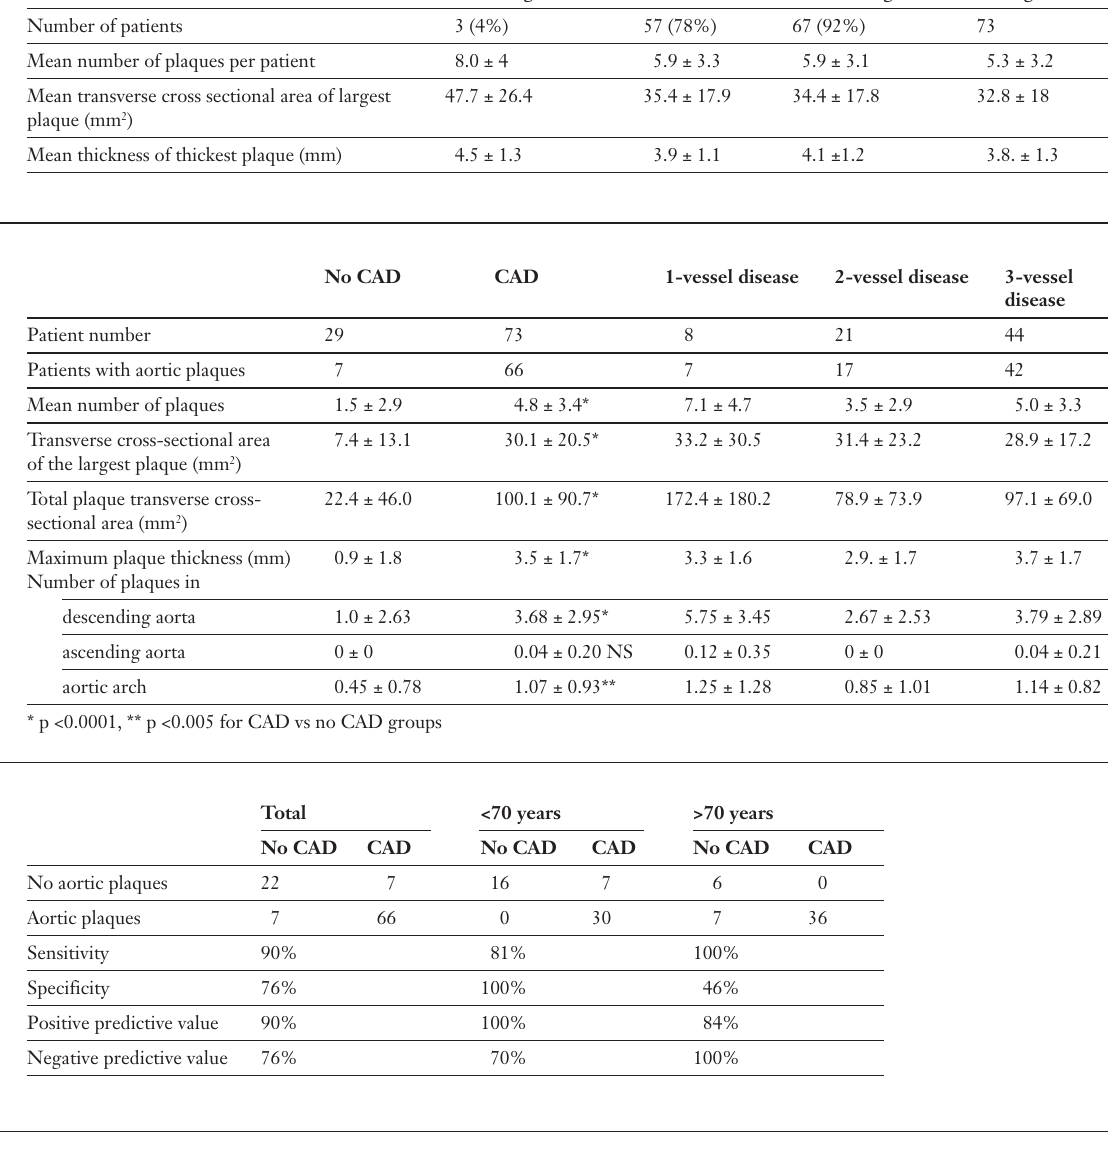
tients with more risk factors, although a wide scat- ter is